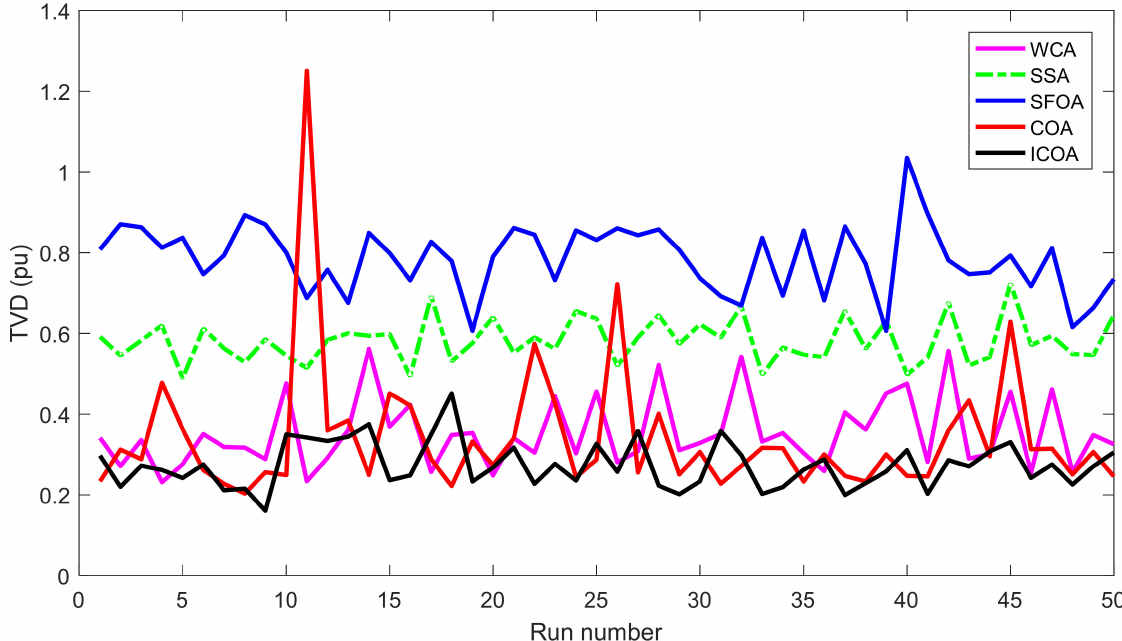
Figure 10. TVD of 50 runs obtained by different methods for the IEEE 118-bus